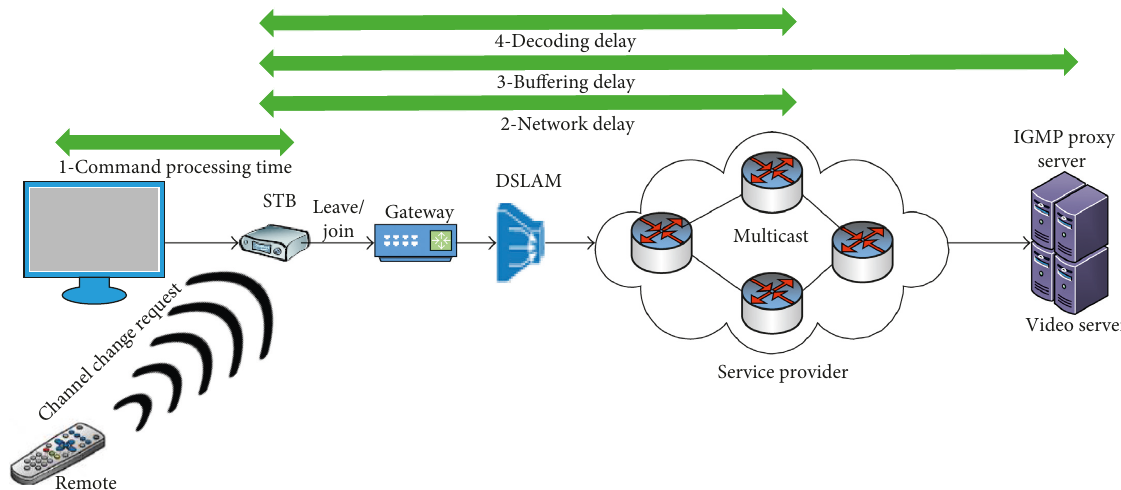
Figure 2: Factors of zapping delay in a converged network.